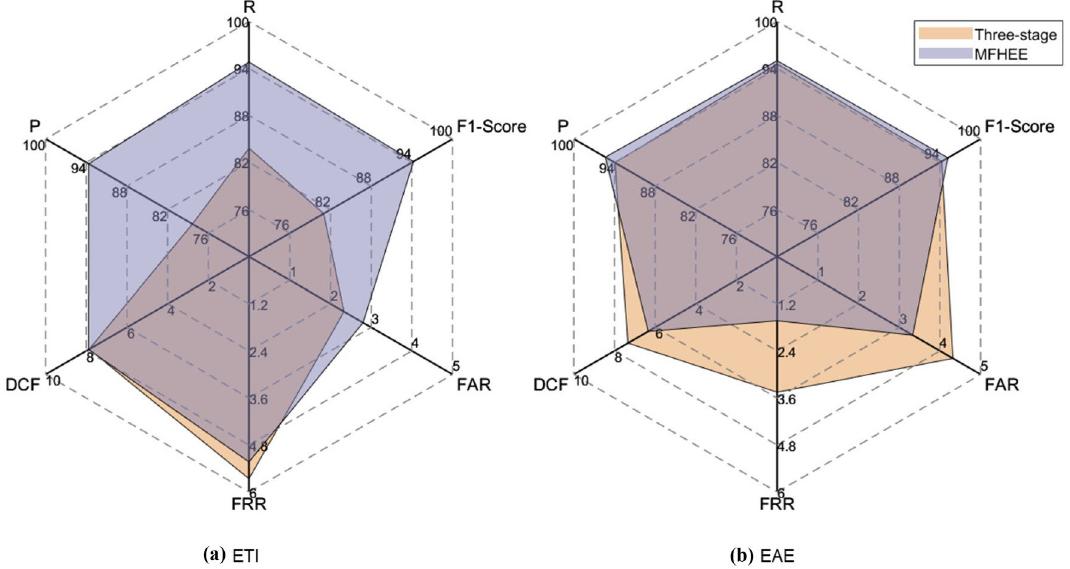
Fig. 7 Radar diagram of comparative experiments results on CCR dataset